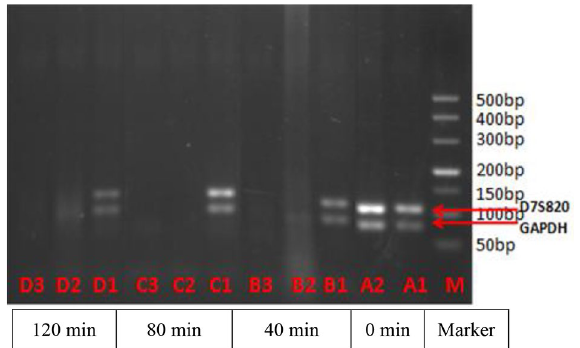
Figure 6. Electrophoresis results of GAPDH and TH01 in DNA in the mouse stomach and small intestine contents. Lane M: 500 bp DNA marker. Lanes A1 and A2: pre-gavage (0 min). Lanes B1–B3, C1–C3 and D1–D3: post-gavage at 40, 80 and 120 min, respectively. Lanes B1, C1 and D1: DNA of stomach contents, with GAPDH (106 bp) and D7S820 (77 bp) bands. Lanes B2, B3, C2, C3, D2 and D3: DNA of small intestine contents, with no amplified DNA